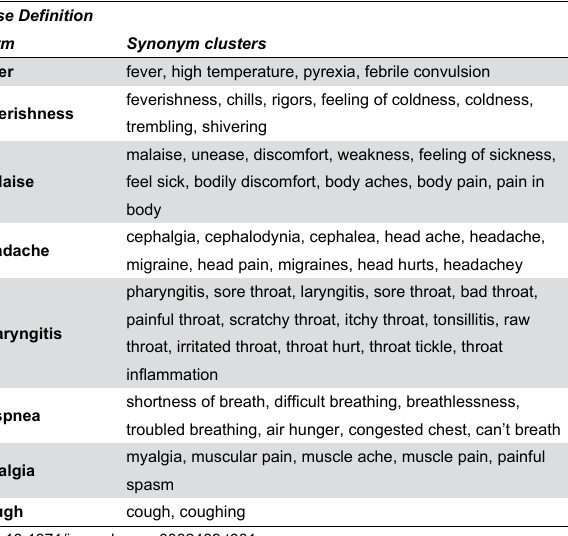
Algorithm development: extraction of naïve-medical